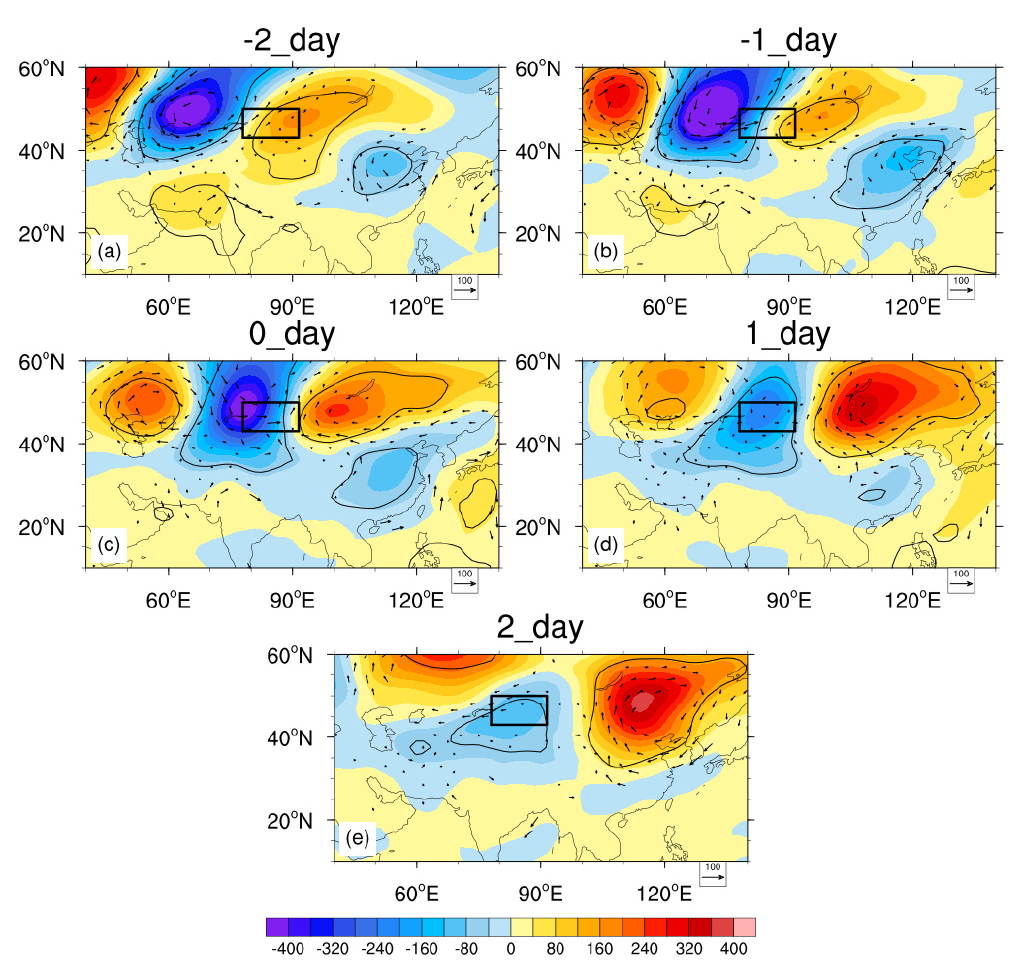
Figure 4. Composition of Z500 (contour) and Q anomaly (arrow) of Type WT on the extreme precipitation day and two days before and after ( a – e ) in the summers of 1979–2018 (Unit: gpm). The black box represents the location of the Northern Xinjiang region. The region over the 95% significant confidence level of geopotential height is circled with black lines, and only the part over the 95% significant confidence level of surface water vapor flux is shown.